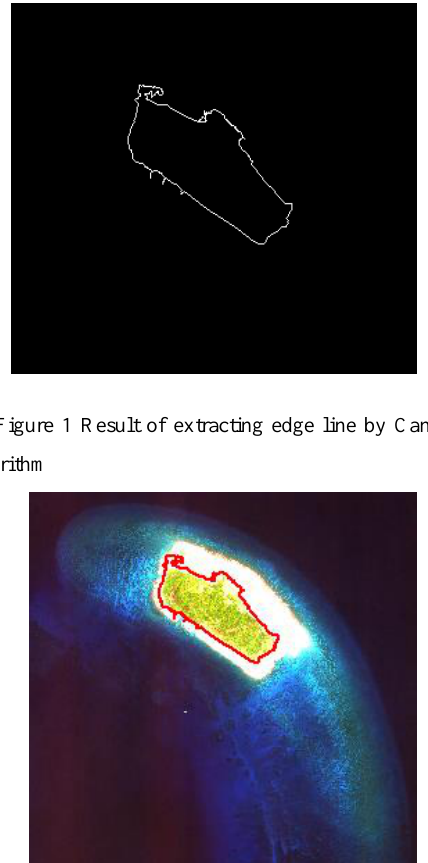
Figure 2 Overlapping of estimated edge and